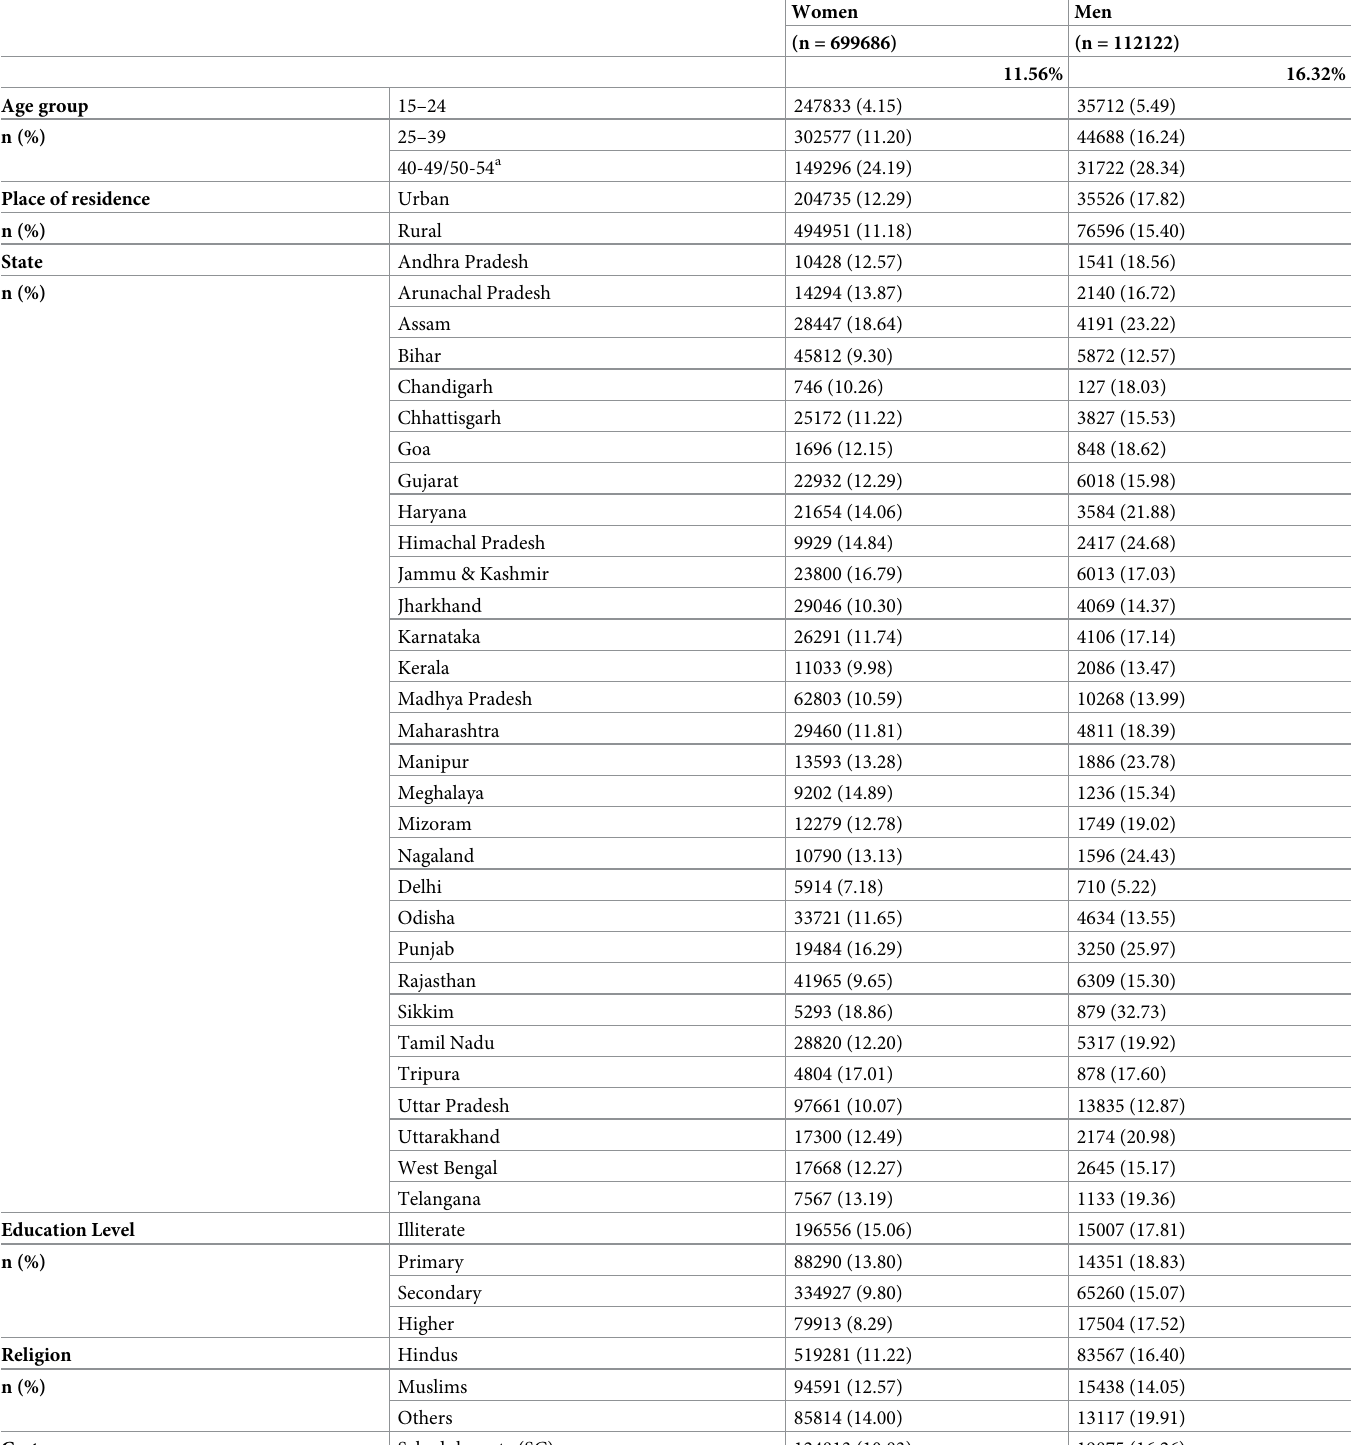
Table 1. Prevalence of hypertension among women and men stratified by socio-economic, demographic and lifestyle background